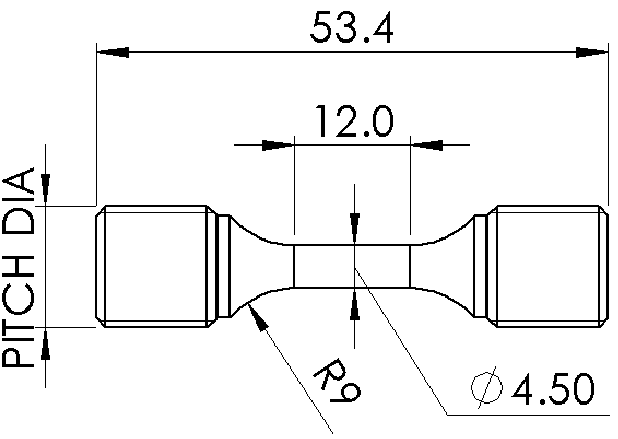
Figure 2. Round cylindrical specimen geometry. (dimensions in mm)